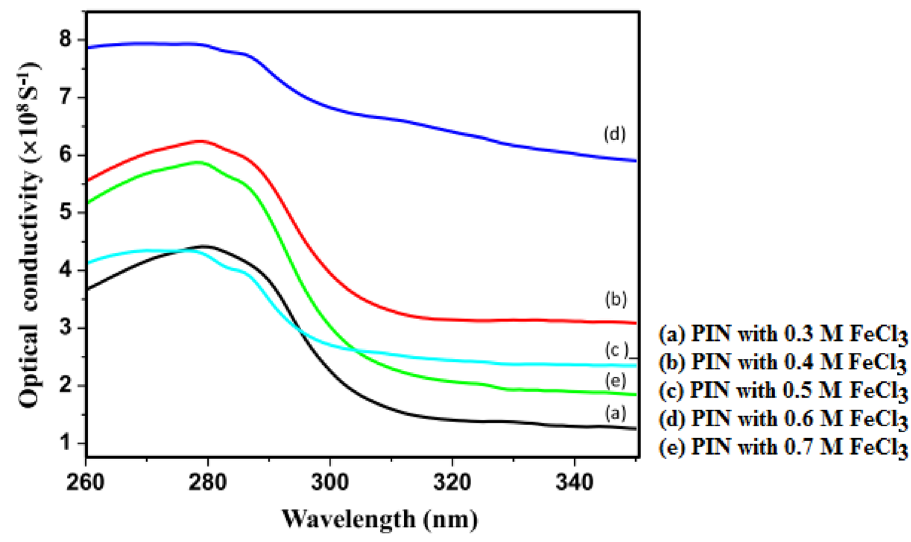
Fig. 11 Relation depicting rela- tion between optical conductiv- ity and applied wavelength